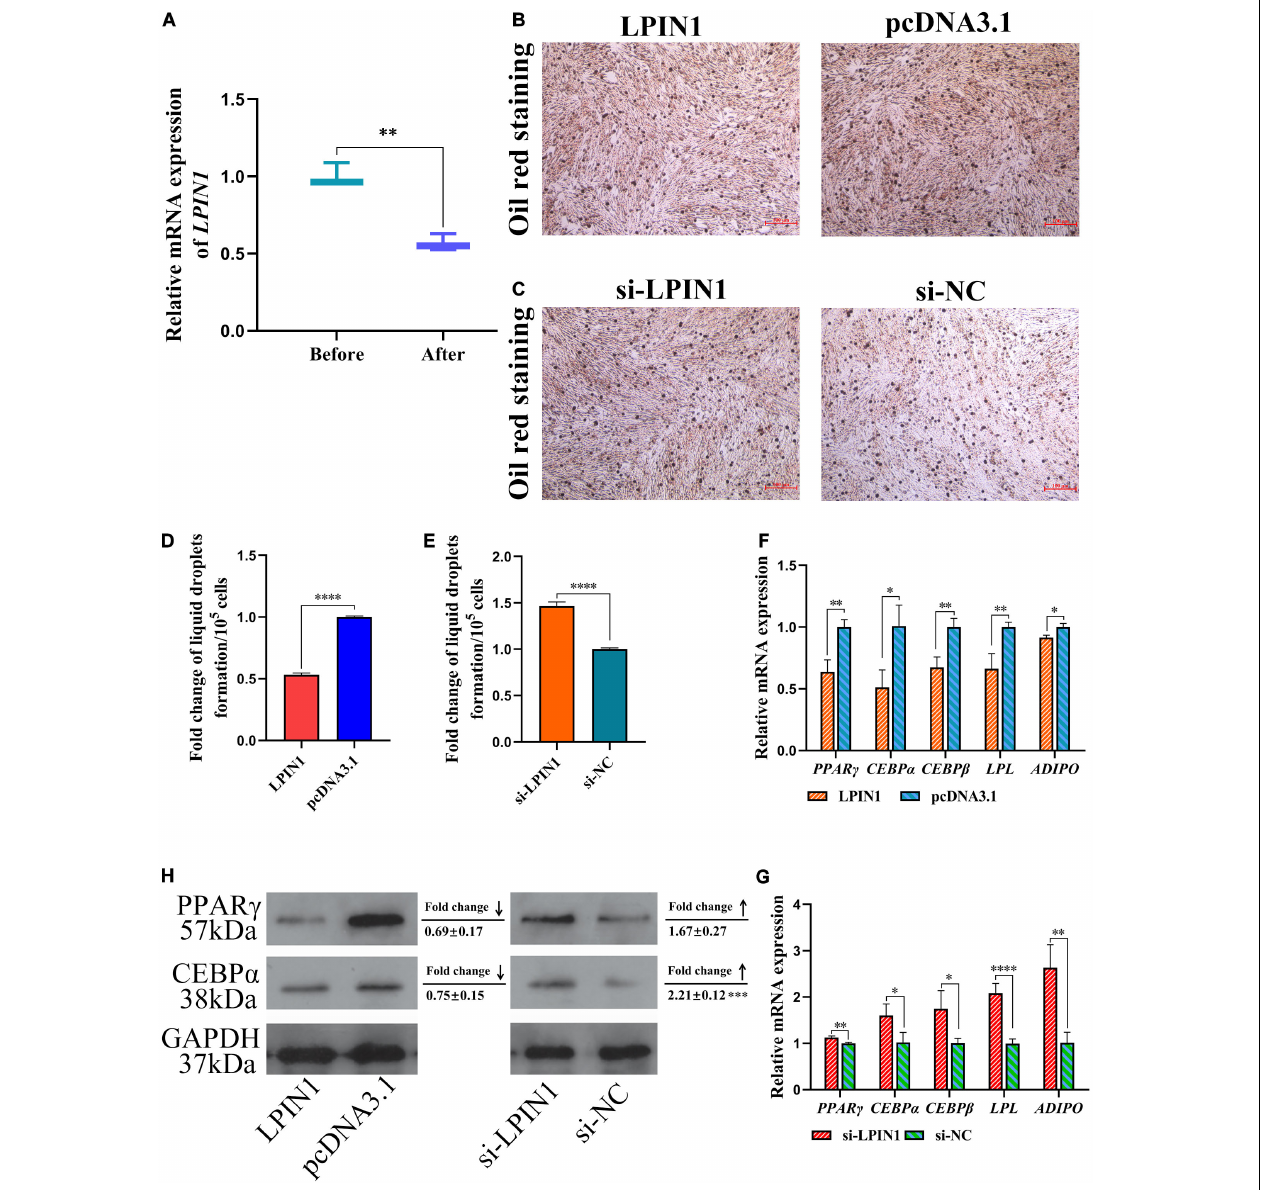
FIGURE 9 | LPIN1 suppresses preadipocytes differentiation by inhibiting PPAR γ pathway. (A) Relative mRNA expression of LPIN1 before and after preadipocytes differentiation. (B,C) Oil red staining for lipid droplet formation. (D,E) The fold change of lipid droplets formation per 10 5 cells. (F,G) Relative mRNA expression of PPAR γ , C/EBP α , C/EBP β , LP L, and ADIPO in in ICP-1 cells. (H) The western blot for PPAR γ and C/EBP α proteins in ICP-1 cells. Data presented as mean ± SEM, * P < 0.05; ** P < 0.01; *** P < 0.001; **** P < 0.0001; ns: no